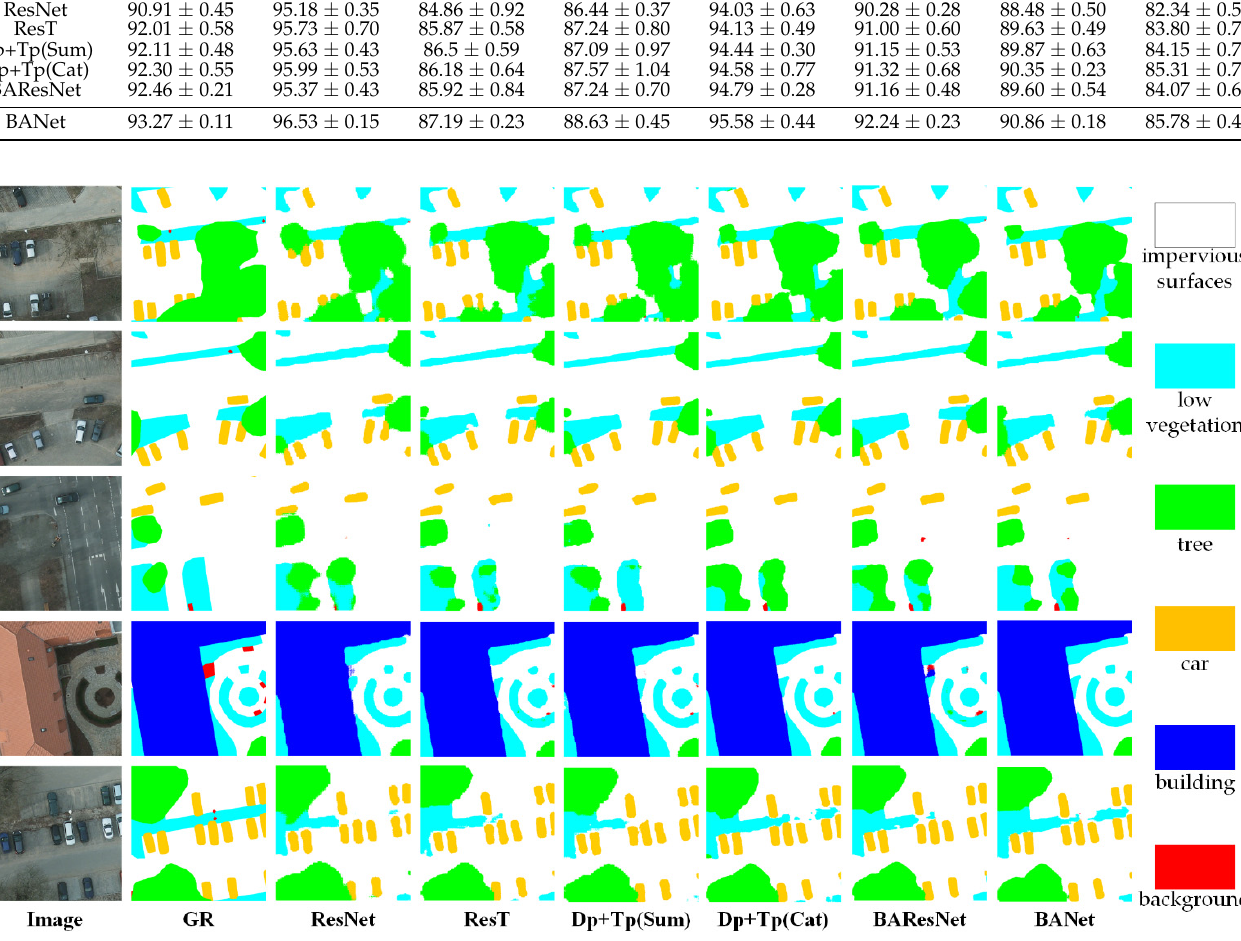
Figure 12. The ablation study on the ISPRS Potsdam dataset. GR represents Ground Reference. Table 4. The experimental results of the ablation study.